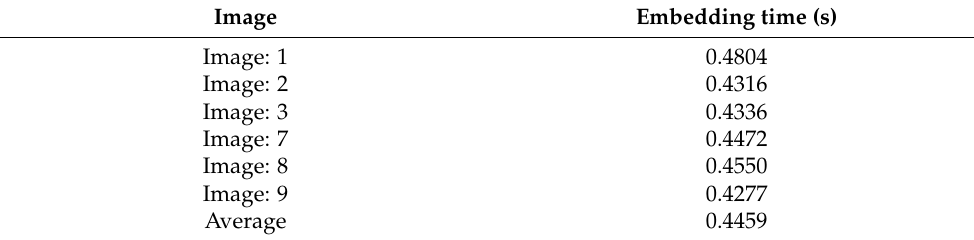
Table 3. Embedding time of the proposed scheme (in